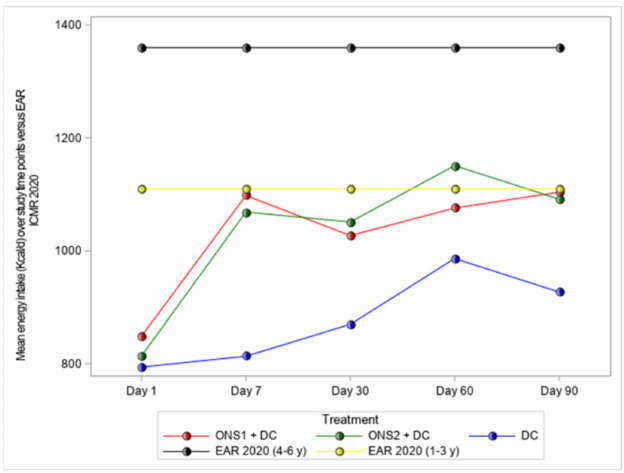
Figure 5. Mean energy intake (Kcal/d) compared to EAR 2020* at baseline and follow-up timepoints. * EAR for energy is equivalent to the estimated energy requirement